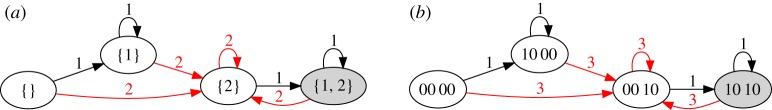
Return-point memory (RPM). (a) Minimal schematic for the case of two driving amplitudes and starting from a featureless state, as in figure 1. The order in which memories are written is important: to reach the multiple-memory state {1, 2}, the last driving must have amplitude 1. (b) The smallest realization of our ferromagnet model shows RPM. The multiple memory state 10 10 may only be reached by writing the small memory (γ = 1) after the large one (γ = 3). (Online version in colour.)